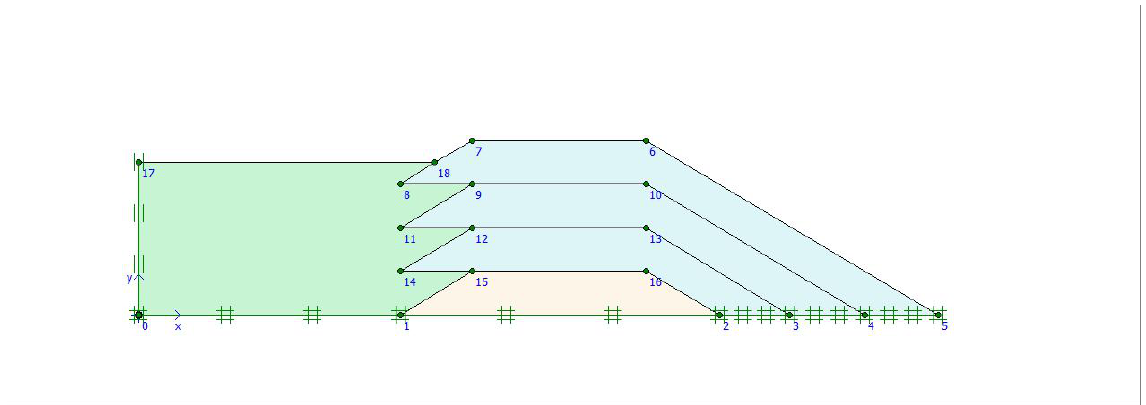
Figure 12. Cross section of centrroid method dam with its